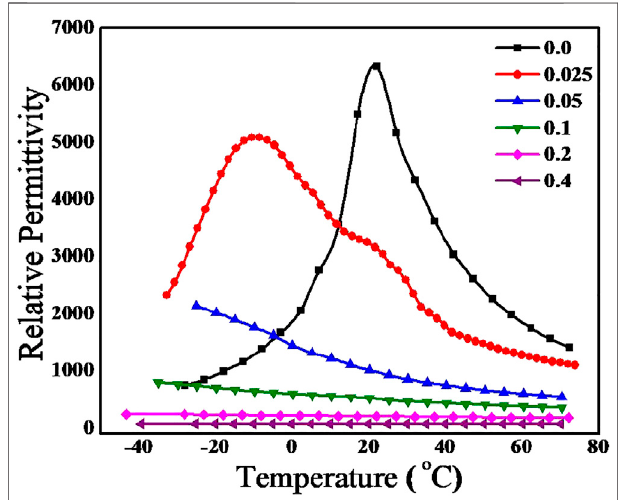
FIGURE 5 | Variation of relative permittivity of BaZr 0.2 [Ti (1-x) Mg x/3 Ta 2x/3 ] 0.8 O 3 for 0.0 < x < 0.4 with temperature at 1 MHz.